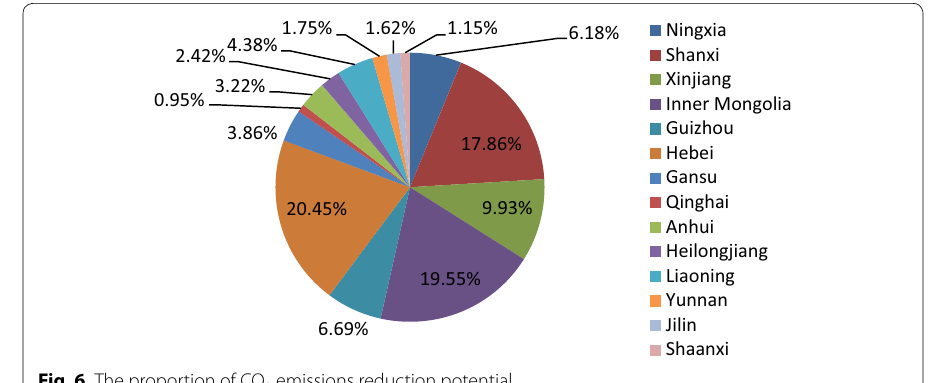
Fig. 6 The proportion of CO 2 emissions reduction